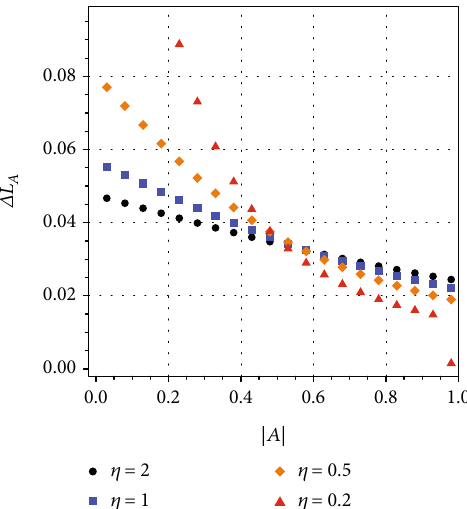
Figure 3: The two-point correlation functions for a charged accelerating AdS Black hole with respect to the acceleration parameter A . Here, we take q = 0 : 01 , m = 0 : 1 , ℓ = 1 , θ